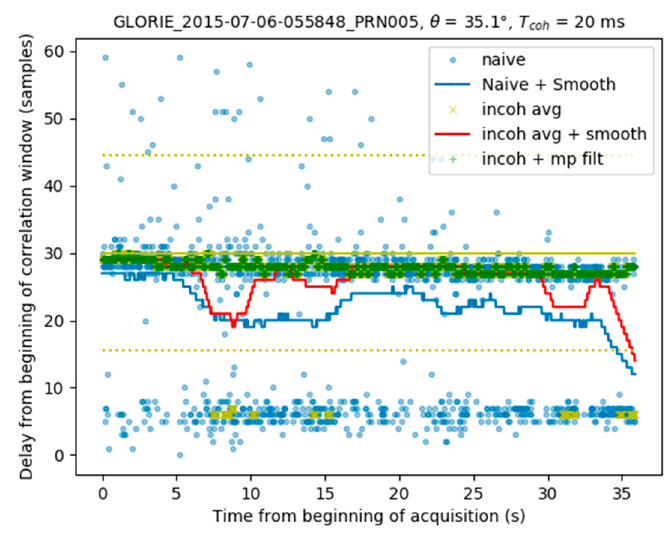
Figure 11. Peak search within the new window, after incoherent integration.